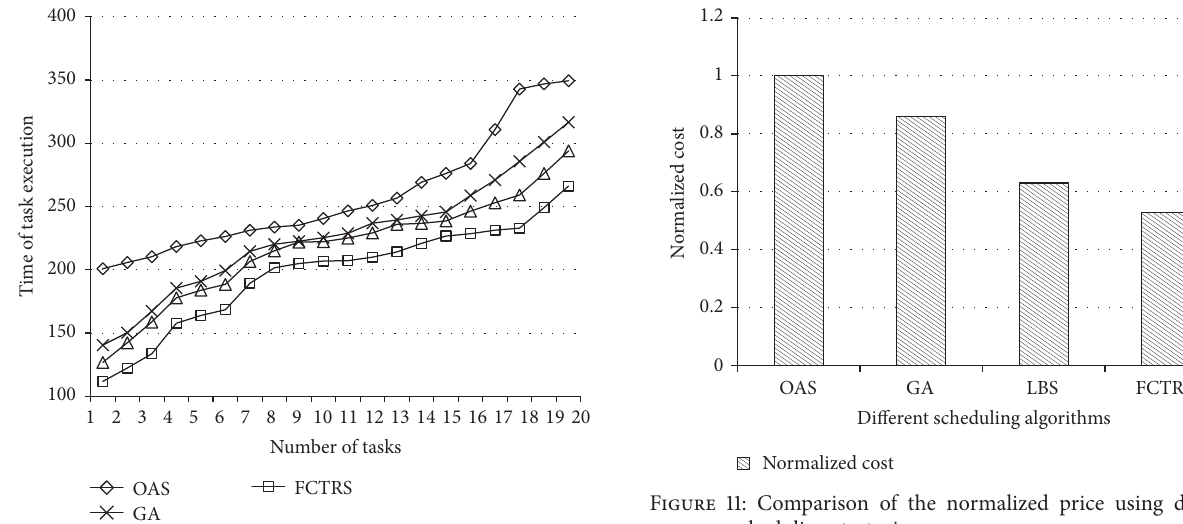
Figure 11: Comparison of the normalized price using different resource scheduling